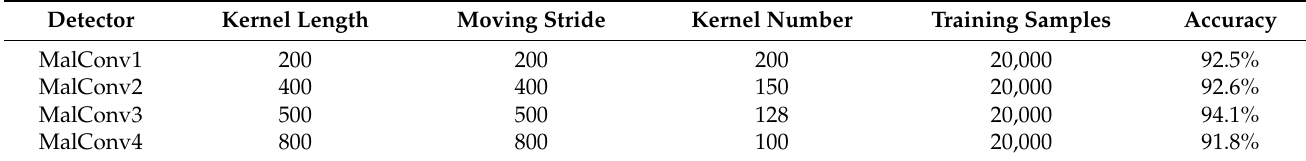
Table 1. Parameter setting for